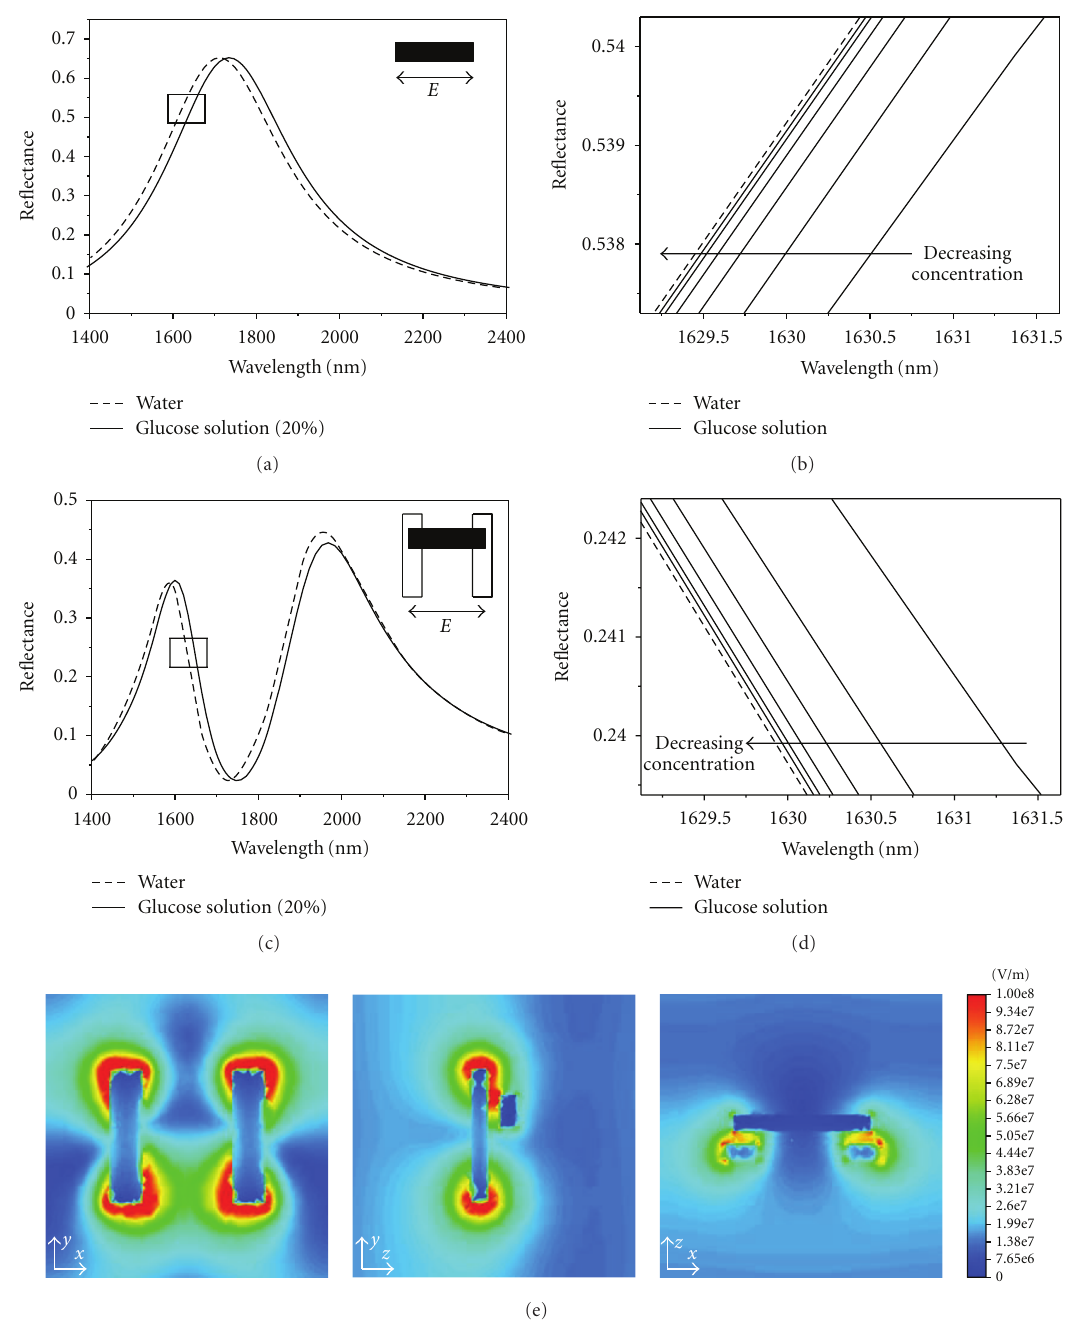
Figure 3: S-matrix simulations of a simple dipole structure (a) and a coupled dipole and quadrupole antenna (c) with water and 20% glucose solution on top. A detailed view for smaller concentrations ranging from 1.25% down to 0.04% is given in (b) and (d), respectively. Figure (e) depicts the time averaged absolute values of the electric field in and around the structure at the resonance